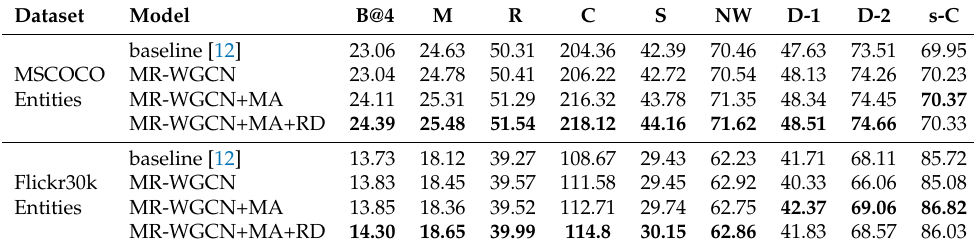
Table 1. Settings and results of ablation studies. (Baseline: ASG2Caption [12]; MR-WGCN: replace MR-GCN in baseline model with the proposed MR-WGCN; MR-WGCN+MA: replace MR-GCN and insert memory-augmented attention(MA); MR-WGCN+MA+RD: replace MR-GCN with MR-WGCN, insert memory-augmented attention (MA) and relational discriminator (RD) into the baseline model). Bold for the